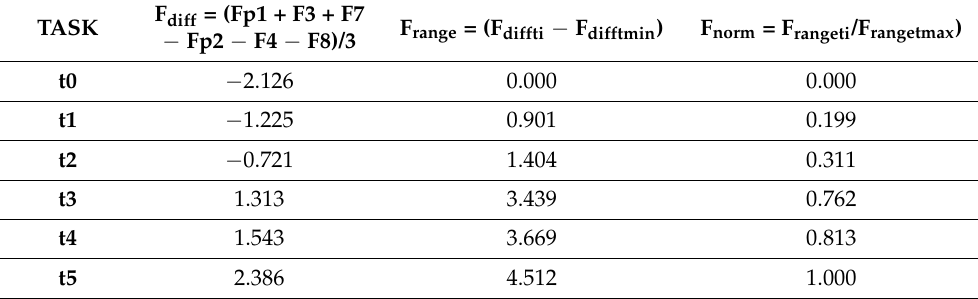
Table A2. Difference between left and right frontal region in theta rhythm spectral power during task 2.